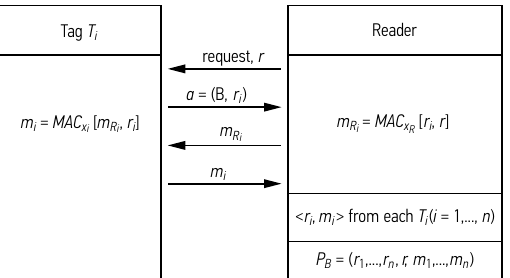
Fig. 3 . Modified proof for more than 2 tags